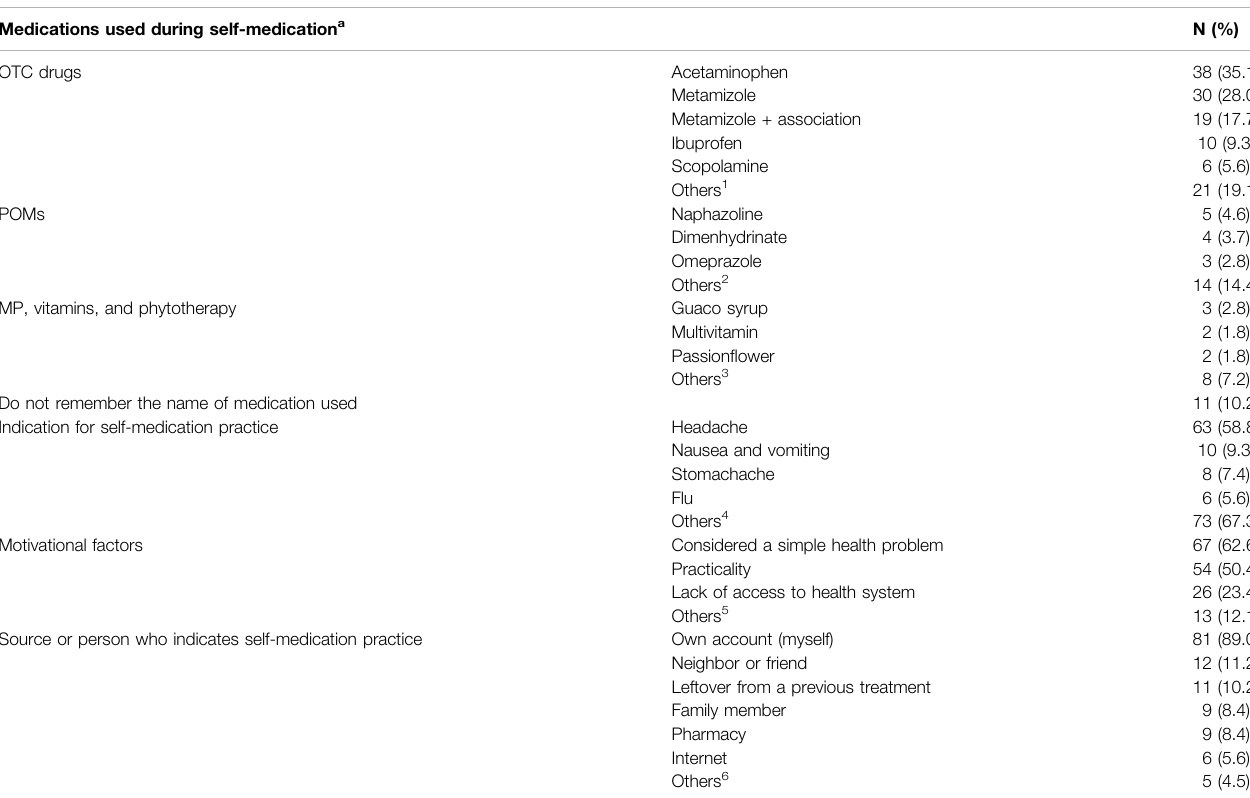
TABLE 3 | Main characteristics related to self-medication during pregnancy. Medications used during self-medication